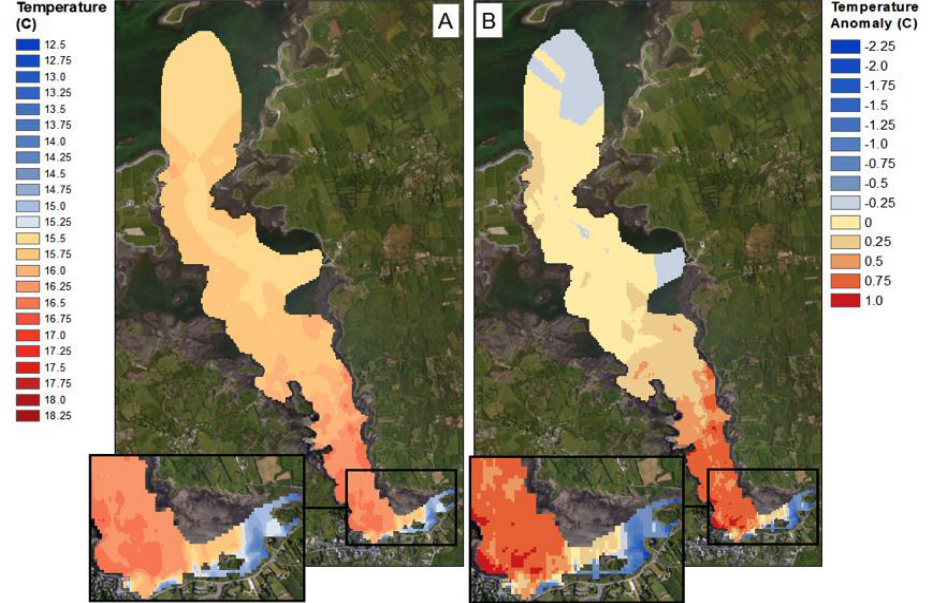
Figure 7. Sea surface temperature map of Kinvara Bay interpolated from in-situ data measurements ( A ); Temperature anomaly map showing surface temperature divergence from the mean ( B ).